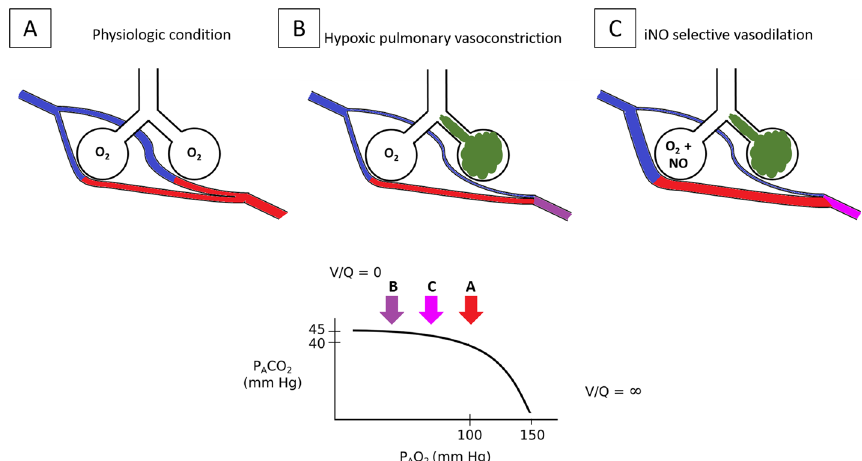
Fig. 3 iNO reversal of hypoxemia and pulmonary hypertension during HPV. iNO is a pulmonary selective vasodilator. It diffuses selectively from ventilated alveoli to the adjacent pulmonary capillaries. This reduces PVR and the right ventricle afterload. The selective vasodilation of oxygenated vessels diverges pulmonary blood flow towards the ventilated alveoli. As a consequence, pulmonary shunt is reduced and arterial oxygenation is increased. In physiologic conditions, most of the alveoli are well ventilated and perfused, as low PVR ensures that a wide pulmonary capillary bed is recruited ( A ). If some of the alveoli are poorly or not ventilated (e.g., atelectasis, pneumonia), the pulmonary capillaries that perfuse those alveoli constrict because of HPV. The increased PVR leads to a consequent reduction of the available pulmonary vascular bed. This limits the blood perfusion of the poorly/not ventilated lung areas then limiting V/Q mismatch and pulmonary shunt ( B ). The administration of iNO in the presence of HPV increased the vasodilation of pulmonary vessels that are normally ventilated. This condition reduces PVR and reverses hypoxemia by diverging the blood flow to ventilated areas, thus reducing V/Q mismatch and pulmonary shunt ( C ). The P A O 2 -P A CO 2 graph below, represents the partial pressure of the alveolar gases in each of the conditions previously described. In physiologic conditions, the V/Q is optimal ( A arrow); when some the alveoli are not ventilated, hypoxemia emerges because of pulmonary shunt despite the compensatory mechanism of HPV ( B arrow). This condition may be partially reverted by the administration of iNO ( C arrow). The bottom panel was adapted from West JB, Luks AM. West’s Respiratory Physiology. The Essentials. Tenth Edition. Wolters Kluwer, 2015.